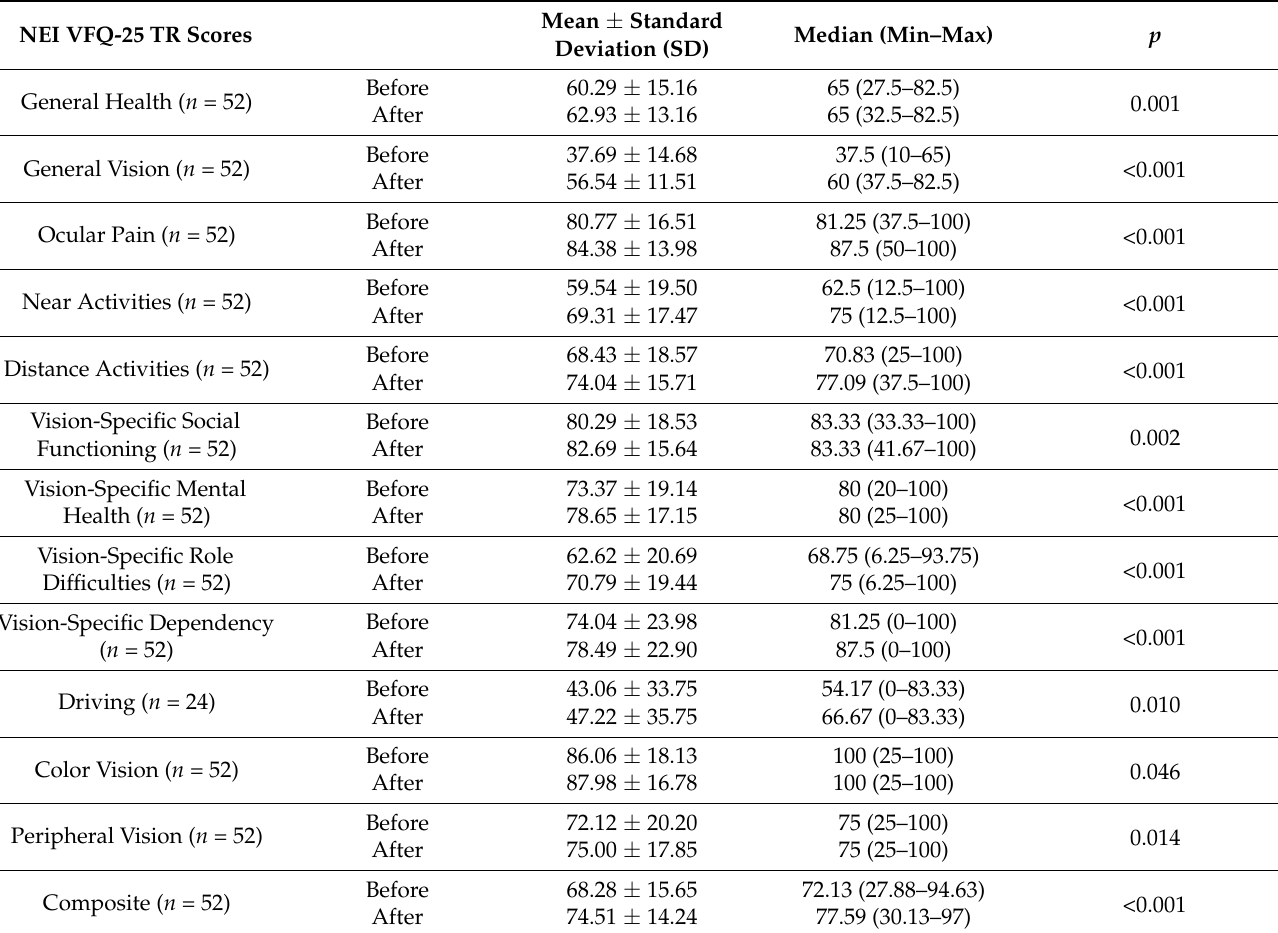
Table 3. Summary of NEI VFQ-25 TR subscale and composite scores before (baseline) and after treatment (1 month after the third